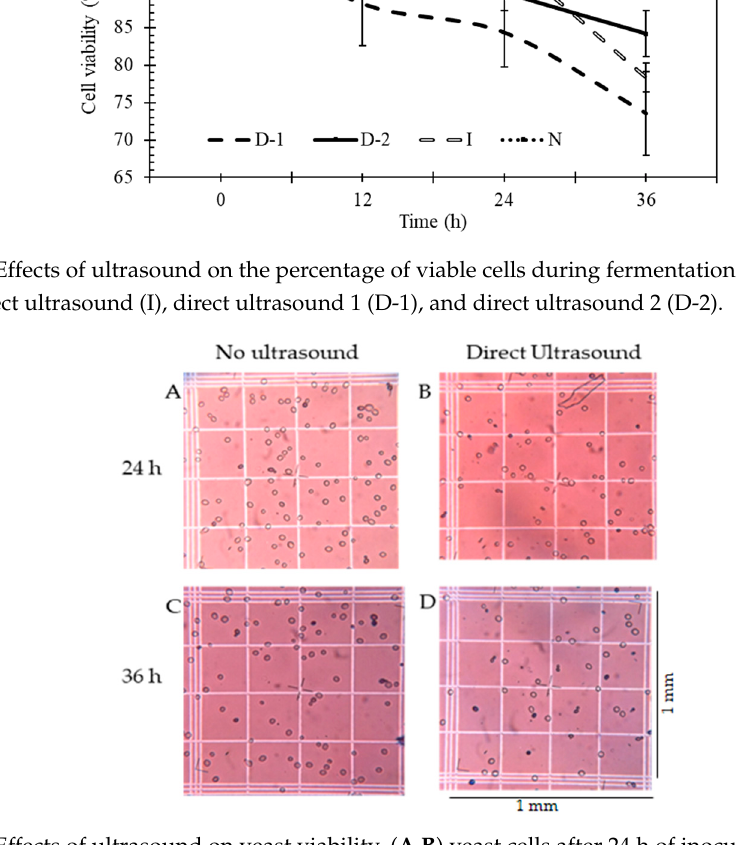
Figure 8. Effects of ultrasound on yeast viability. ( A , B ) yeast cells after 24 h of inoculation for N and D-1, respectively; and ( C , D ) 36 h after inoculation for N and D-1, respectively. Each square with a triple line border represents approximately 1 mm 2